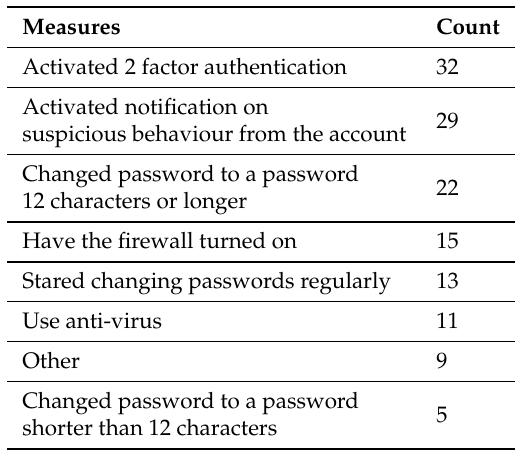
Table 27. Measures users who have had their accounts compromised have activated to help mitigate a new compromise. N =